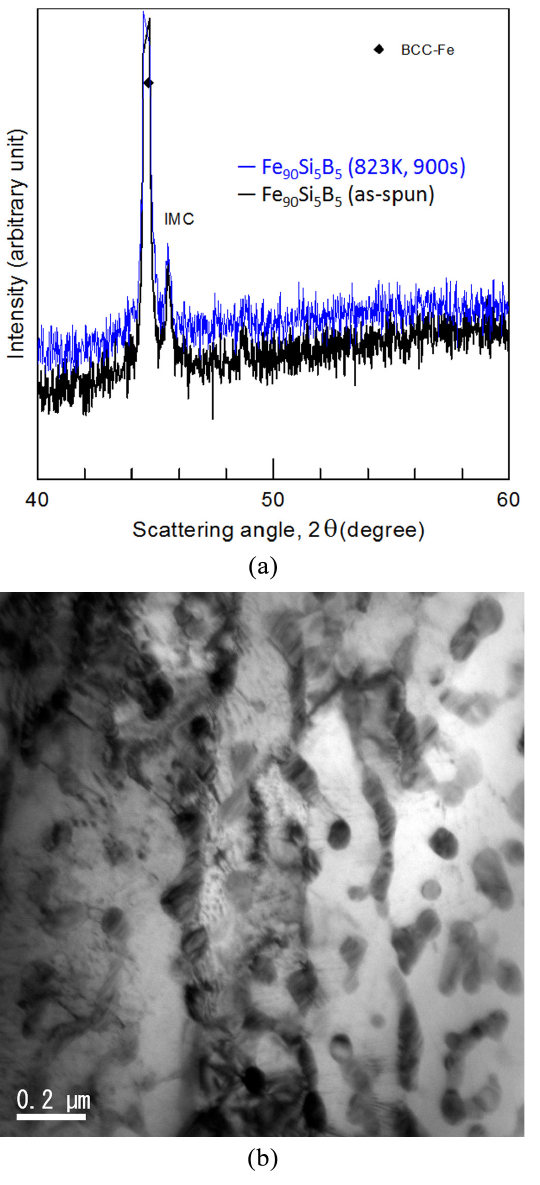
Figure 9. Field-magnetization plot of Fe Fe Si B ribbon as-spun alloys: (a) as-spun and (b) annealed at 90 7.5 2.5 823K for